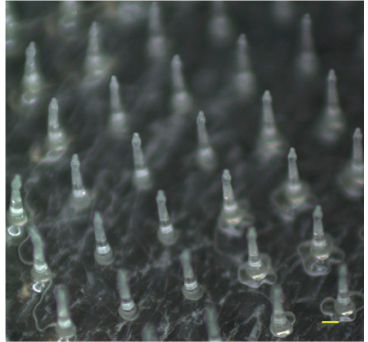
Figure 1. Micrograph of ALN(TIP)–MN (tip-ALN-loaded hyaluronic acid MN). Scale bar: 400 µm.